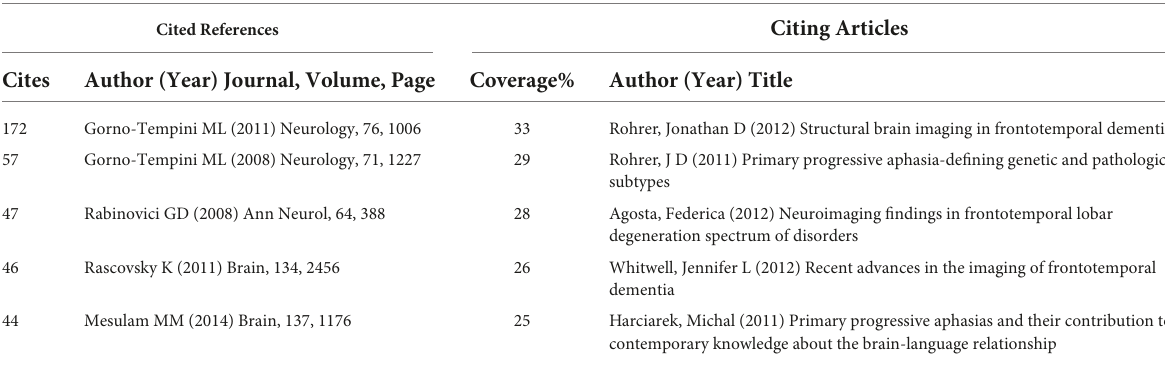
TABLE 7 Cited references and citing articles of Cluster #3 on frontotemporal